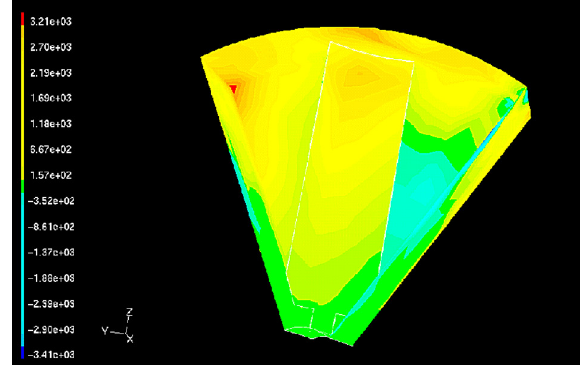
Figure 9: Calculation domain used in FLUENT simulation.